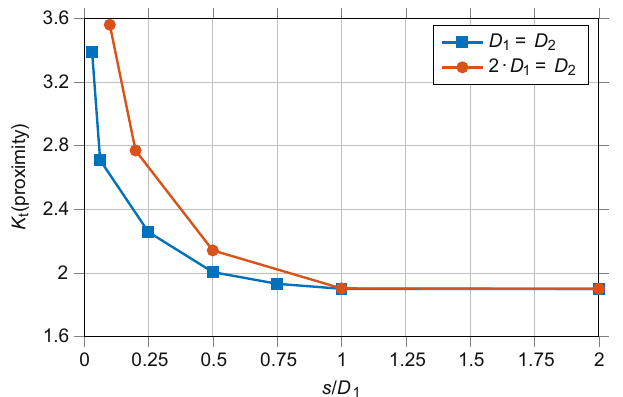
Figure 7. The stress concentration ( K t ) resulting from pores in close proximity to one another – The maximum increase in stress predicted by linear elastic FE modelling of two idealised spherical pores in close proximity. Loading is normal to the vector between pore centres. The separation ( s ), i.e. solid material, between pore edges has been normalised by the diameter ( D 1 ) of one of the spheres. Results are shown for spheres of equal diameters ( D 1 = D 2 ) and one sphere with twice the diameter of the other (2· D 1 = D 2 ).